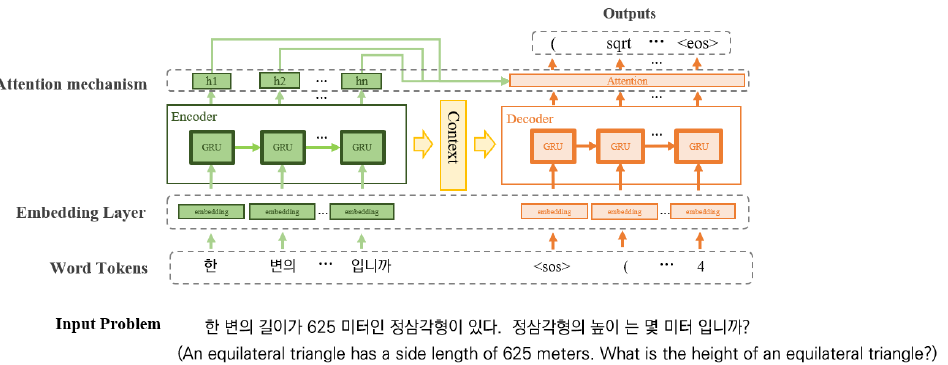
Figure 2. Structure of the seq2seq with the attention mechanism. The green square h represents the hidden state of each word acquired via the